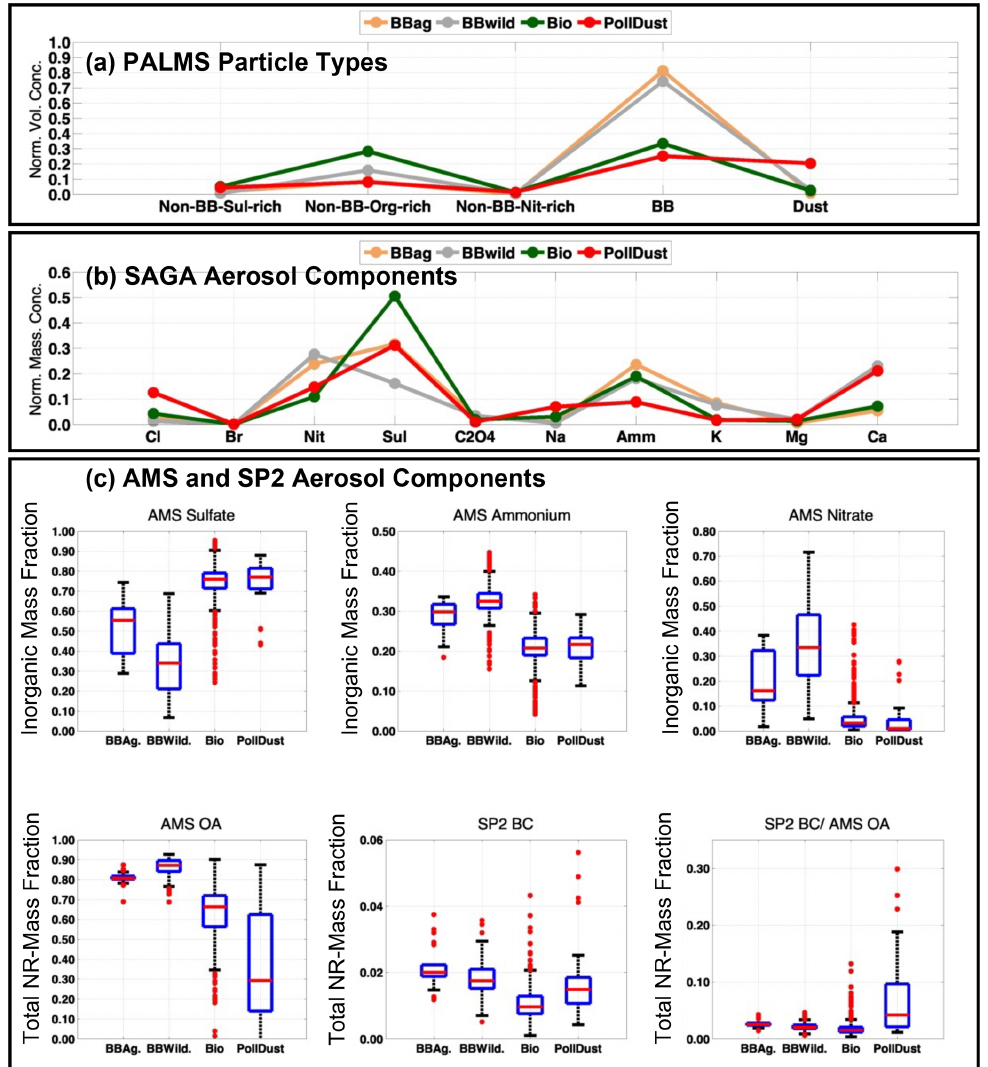
Figure 4. (a) Average PALMS normalized volume concentration per PS-AMT. PALMS normalization uses the sum of BB particles, sulfate-, organic- and nitrate-rich particles from non-BB sources, mineral dust, sulfate–organic–nitrate (SON) particles without a dominant sub- component, and sea salt (the latter two PALMS aerosol types are not shown and constitute the remainder). (b) Averaged and normalized SAGA mass concentrations per PS-AMT; normalization uses the sum of all the SAGA components in the x axis; Cl: chloride; Br: bromide; Nit.: nitrate; Sul.: sulfate; C 2 O 4 : oxalate; Na: sodium; Amm.: ammonium; K: potassium; Mg: magnesium; Ca: calcium. (c) Normalized mass fractions of AMS sulfate, ammonium, nitrate, OA, SP2 BC, and ratio of SP2 BC and AMS OA per PS-AMT. The AMS inorganic mass fraction of sulfate, ammonium and nitrate is normalized to the sum of sulfate, ammonium and nitrate. The AMS and SP2 total non-refractory (NR) mass fraction of OA and BC is normalized to the sum of OA, BC, sulfate, ammonium and nitrate. In each blue box, the red horizontal line indicates the median, and the bottom and top edges of the box indicate the 25th and 75th percentiles, respectively. The black whiskers extend to the most extreme data points not considered outliers, and the outliers are plotted individually using red points. PS-AMTs marine and urban are not analyzed due to their limited number of data points ( N = 9 urban and N = 7 marine